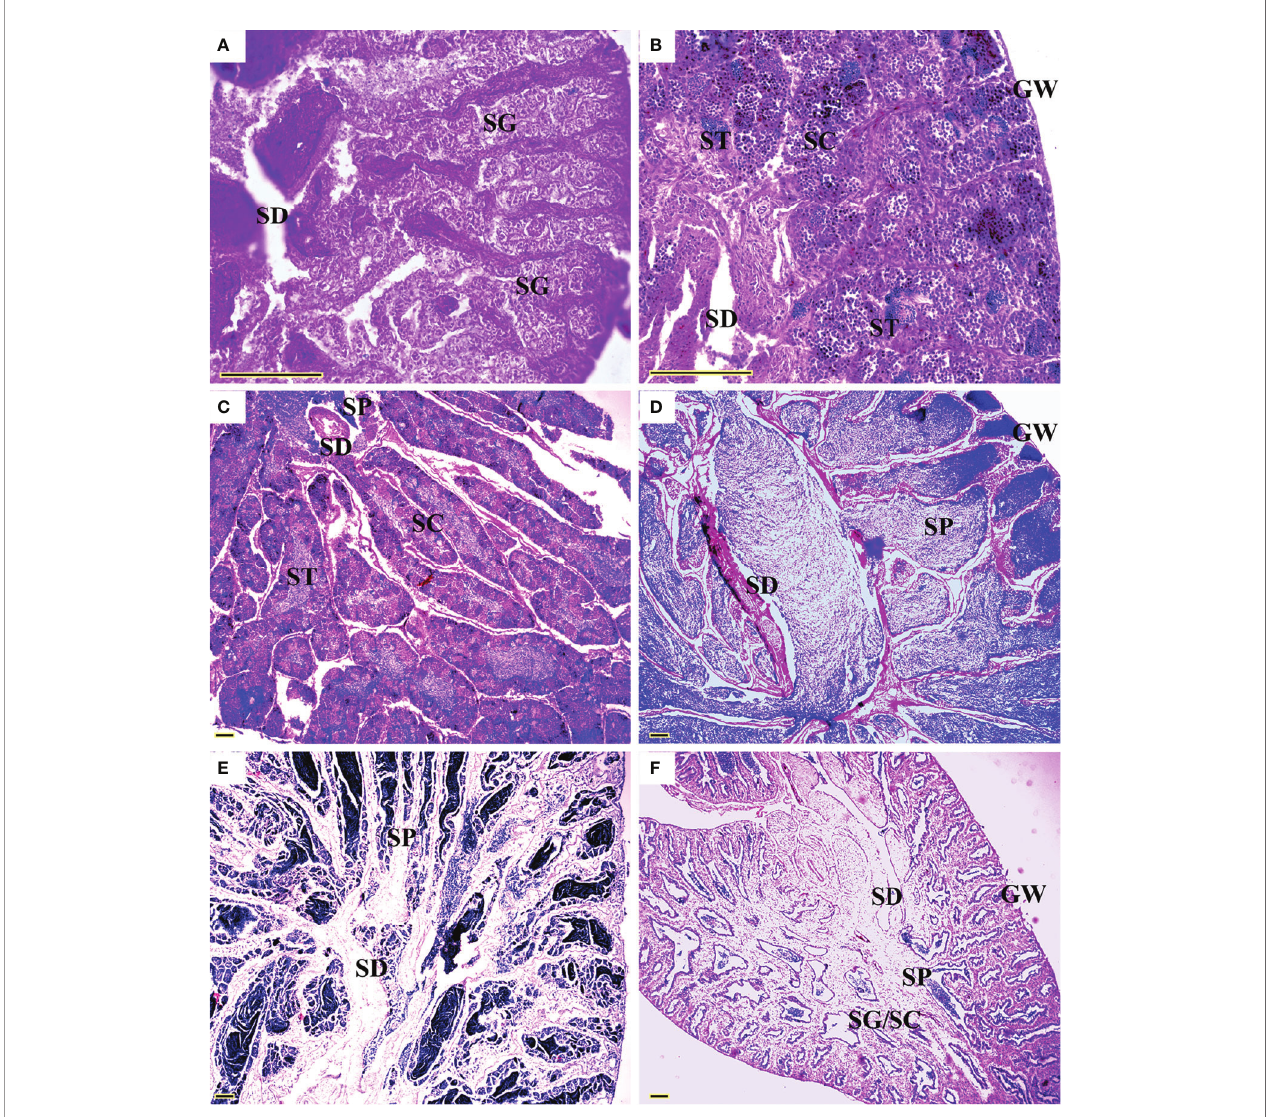
FIGURE 6 | Sexual maturity stages in males of Larimichthys crocea . (A) M1: Immature/resting (144 mm SL, February 2021); (B) M2: Developing (167 mm SL, June 2020); (C) M3: Maturing (175 mm SL, May 2020); (D) M4: Ripe (248 mm SL, February 2021); (E) M4: Ripe (177 mm SL, March 2021); (F) M5: Spent (212 mm SL, July 2021). GW, gonadal wall; SC, spermatocytes; SD, sperm duct; SG, spermatogonia; SP, sperm; ST, spermatids. Scale bars: 100 m